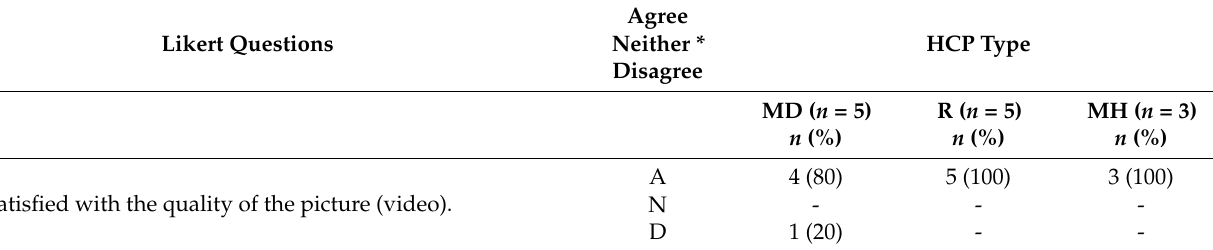
Table 4. Satisfaction survey responses: presented by